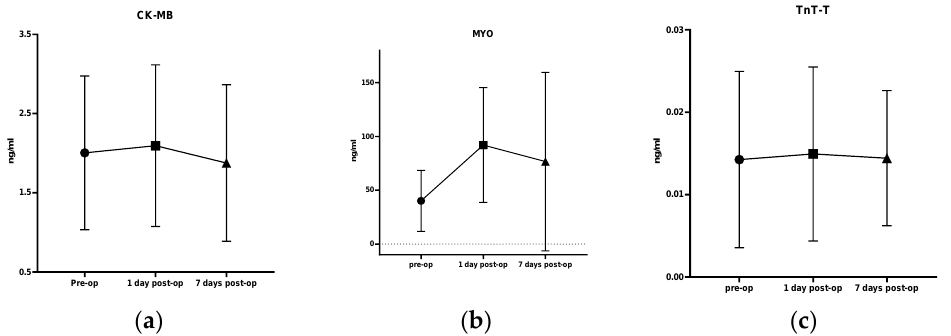
Figure 2. Trends in myocardial markers. This shows trends of the myocardial markers CK-MB ( a ), MYO ( b ), and Tn T-T ( c ) at three different timepoints during the STN-DBS perioperative period. pre-op: pre-operation; post-op: post-operation.